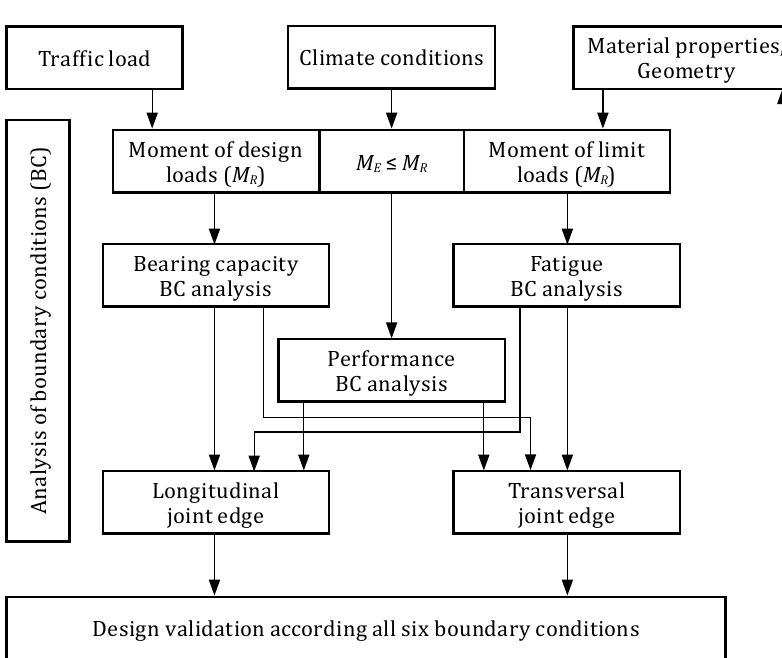
Figure 5. Concrete pavement design based on boundary conditions of design moment M E and limit moment M R (Villaret, Kiehne, Riwe, & Villare,